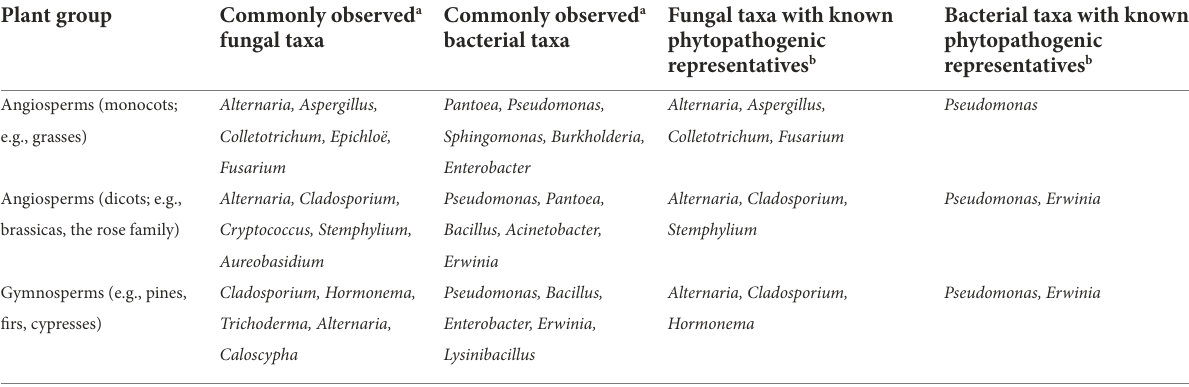
TABLE 1 Commonly found fungal and bacterial taxa in seeds across broad plant